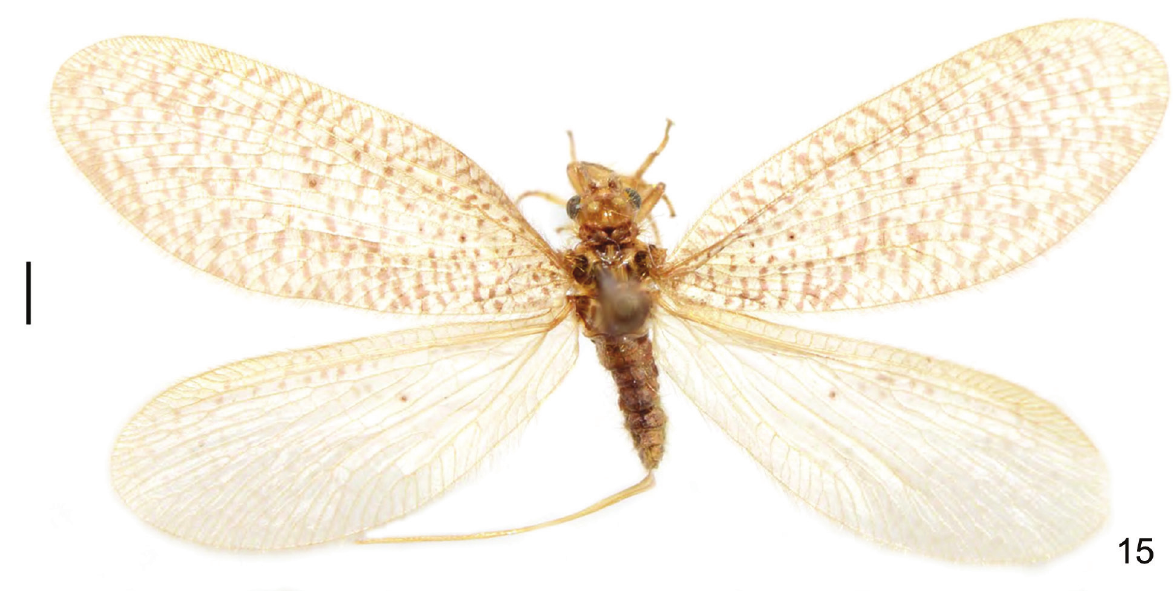
Figure 15. Dilar anatolicus sp. n., paratype, female, habitus (HUAC, Vienna). Scale bar = 1.0 mm.